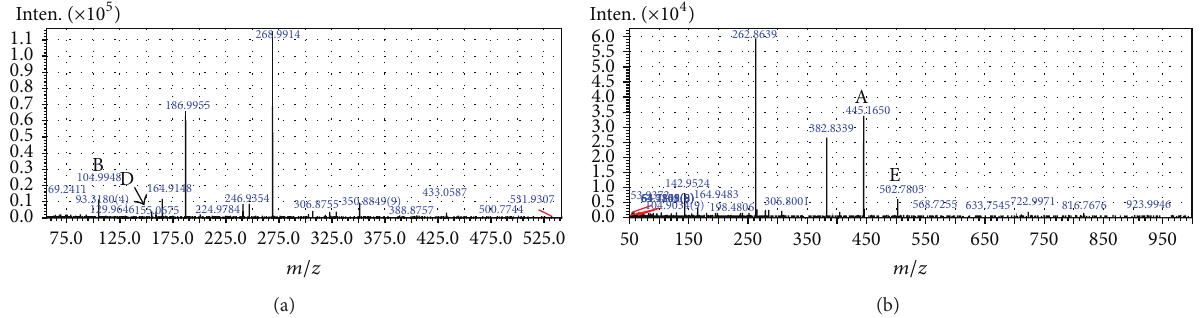
Figure 5: LCMS-IT-TOF results of doxycycline samples submitted to the Fenton process (a) for 60s, retention time of 41s, (b) for 180s, retention time of 54 s. Operating conditions of the Fenton process: 𝐶 doxycycline degradation products with MM = 444 , 104, 154, and 502 g/mol, respectively.